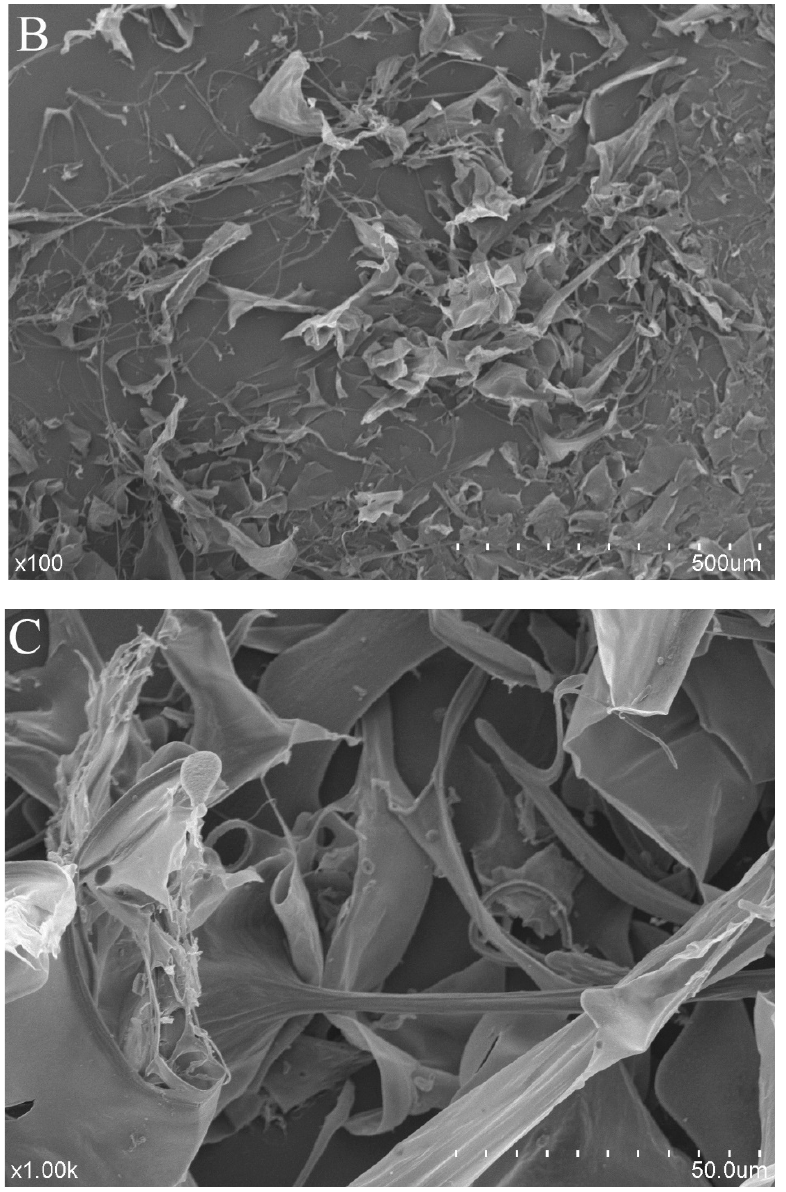
Figure 5. ( A ) Maximum absorption wavelength of Congo red and Congo red + HCPS at various concentrations of sodium hydroxide solution, ( B ) SEM images of HCPS ( × 100), ( C ) SEM images of HCPS ( ×